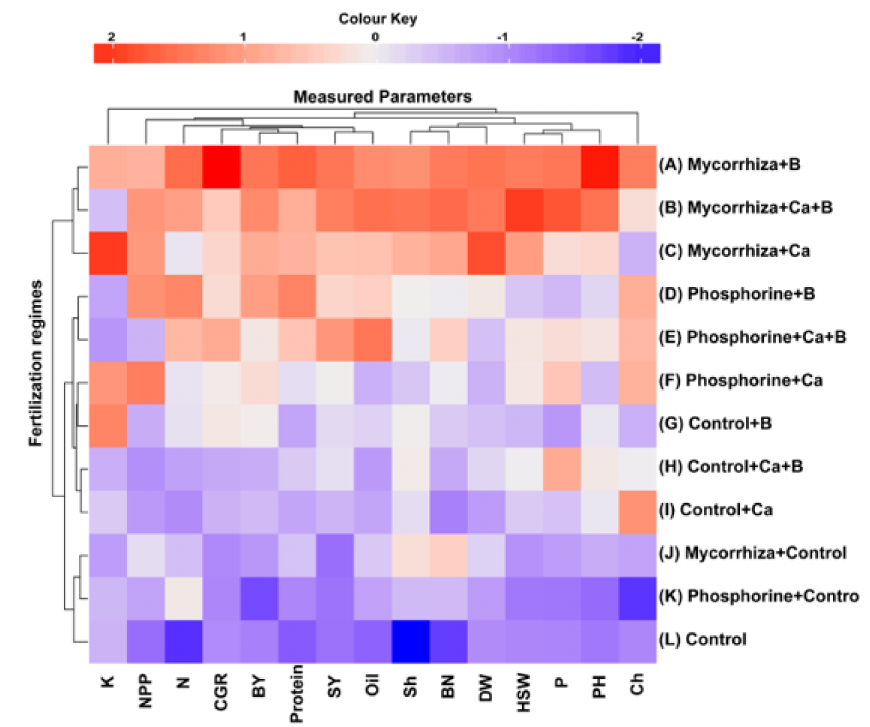
Figure 4. Clustering analysis presented the relationships between fertilization treatment and studied traits. In the ballots, the hierarchical clustering analysis with the Euclidean distance using the principal component scores and Ward’s technique as the process of linkage was used. NPP, number of pods/plants; Sh, shelling; HSW, 100-seed weight; BY, biological yield; SY, seed yield; N, nitrogen; P, phosphorous; K, potassium; CGR, crop growth rate; BN, branching number; PH, plant height; DW, dry weight; Ch,